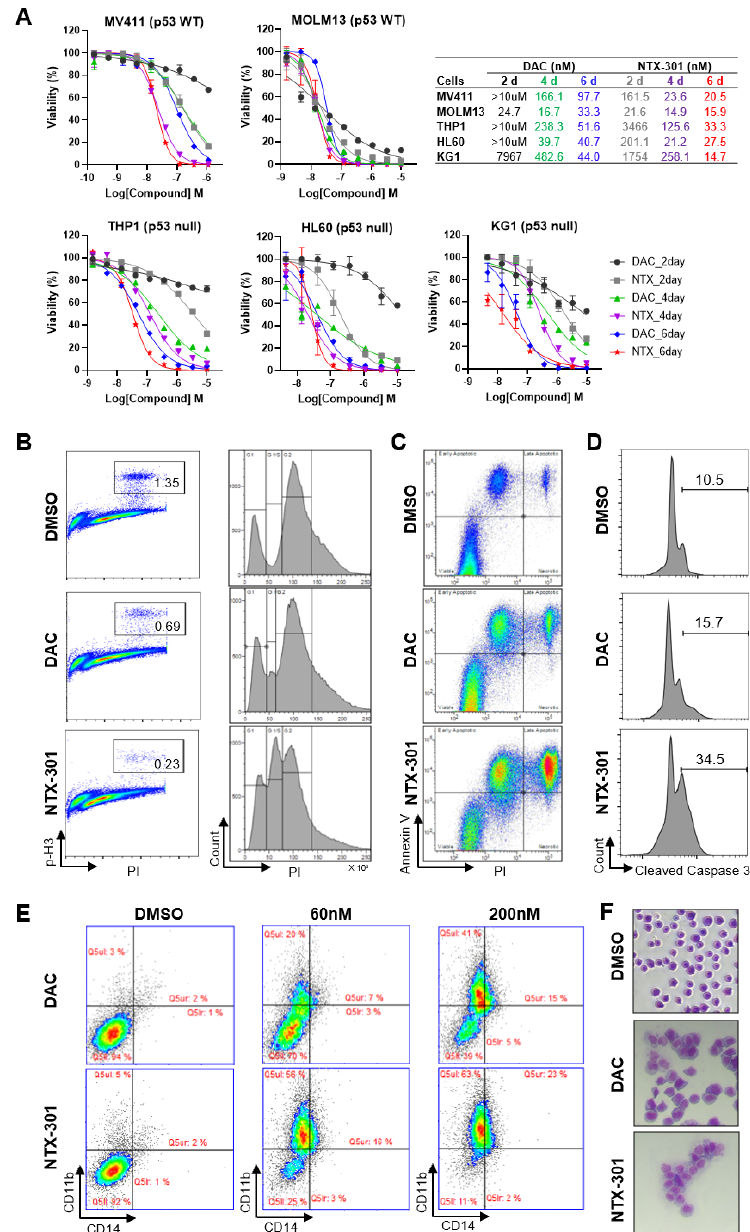
Figure 2. Cell-based phenotypic assays revealed the superior antileukemic activity of NTX-301. ( A ), Dose–response curves of five AML cell lines (MV4-11, MOLM-13, HL-60, THP-1, and KG-1) that were treated with NTX-301 or DAC for the indicated times. The p53 status of the cell lines is shown. ( B – E ), Flow cytometric analyses of MV4-11 cells that were treated with NTX-301 or DAC (500 nM) for 2 days to evaluate cell cycle progression by phospho-histone H3 and PI staining ( B ), apoptosis by Annexin V and PI staining ( C ), and apoptosis by cleaved Caspase 3 and PI staining ( D ), and those treated with NTX-301 or DAC (60 and 200 nM) for 6 days to evaluate AML differentiation by CD14 and CD11b staining ( E ). ( F ), A representative micrograph showing the morphology of MV4-11 cells that were treated with NTX-301 or DAC (60 nM).